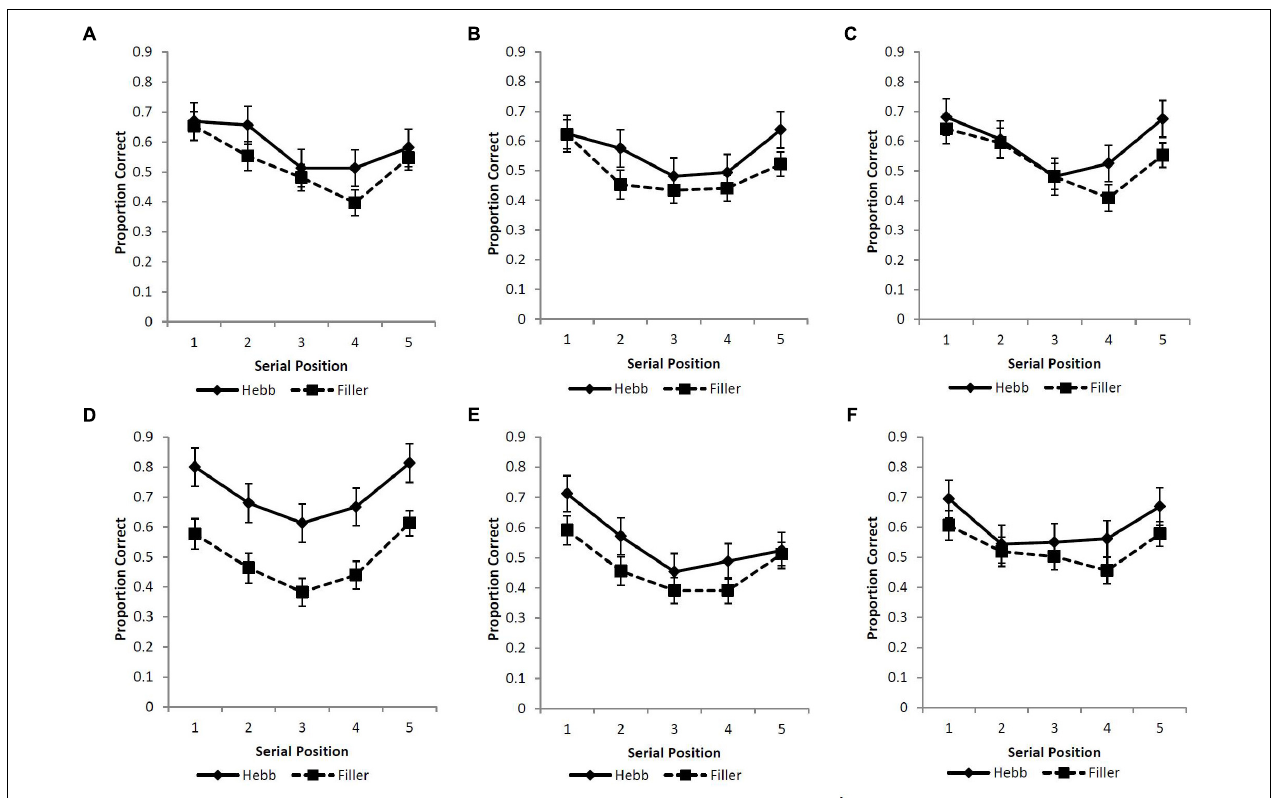
FIGURE 3 | (A–F) Mean proportion correct recall scores for the filler and Hebb sequences as a function of serial position (1–5) for the (A) upright faces under conditions of full-stimulus-overlap, (B) inverted faces under conditions of full-stimulus-overlap, (C) matrices under conditions of full-stimulus-overlap, (D) upright faces under conditions of no-stimulus-overlap, (E) inverted faces under conditions of no-stimulus-overlap, and (F) matrices under conditions of no-stimulus-overlap. Error bars represent the standard error of the